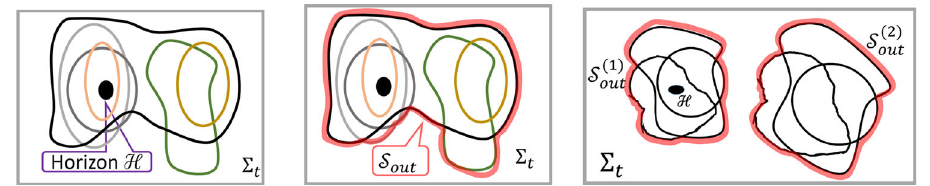
Fig. 2 Left: the circles stand for different photon spheres, which may intersect with each others. Middle: red circle is the “outermost photon sphere”, which is just the enveloping surface of outermost segments